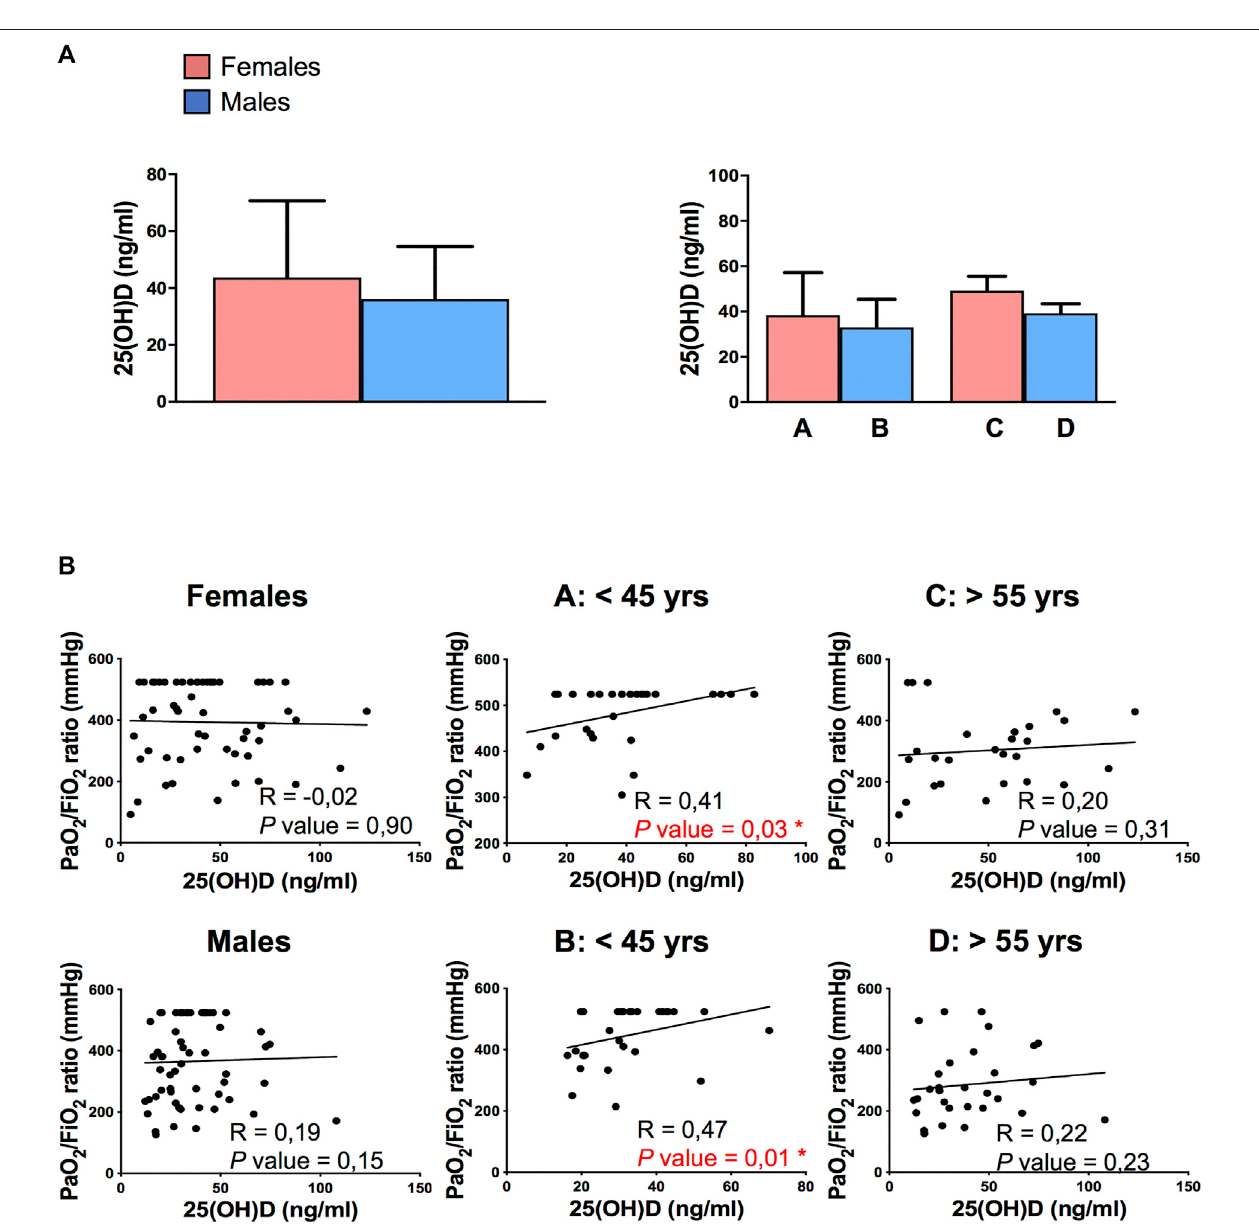
FIGURE1| Detectionofplasmalevelsof25(OH)DanditscorrelationwithPaO2/FiO2ratioinCOVID-19patients. (A) Analysisofplasmalevelsof25(OH)Ddetectedinto female and male patients (left panel) and among the 4 subgroups of patients: A, 40 pre-menopausal females under 45 years; B, 40 males under 45 years; C, 40 post- menopausal females over 55 years; D, 40 males over 55 years. Data referred to plasma levels of 25(OH)D are reported as mean ± SD. (B) Correlation and linear regression analysisofplasmalevelsof25(OH)DandPaO2/FiO2ratioinfemaleandmalepatientscategorizedintofourgroups:A,40pre-menopausalfemalesunder45years(A: < 45yrs); B, 40malesunder 45years (B: < 45yrs); C,40post-menopausal femalesover55years (C: > 55yrs); D,40malesover55years (D: > 55yrs). Asigni fi cantlypositive correlation between plasma levels of 25(OH)D and PaO2/FiO2 ratio is observed in subgroups A and B. The Spearman's rho (R) and P values were determined using the Spearman's rank correlation analysis. Solid lines represent best fi ts as estimated by linear regression analysis. *, P < 0.05 was considered statistically signi fi cant.